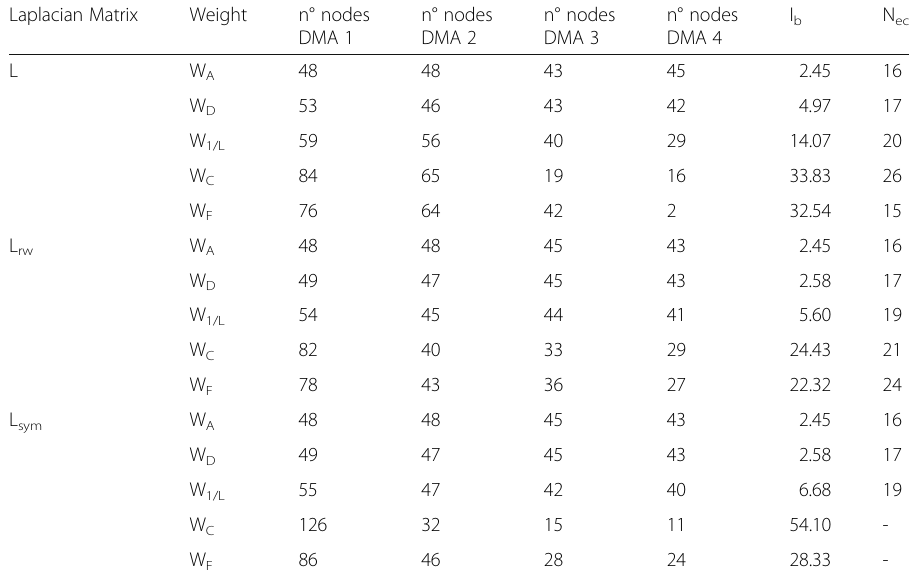
Table 3 Characteristics of the clusters obtained with the three tested algorithms and the five adopted pipe weights Laplacian Matrix Weight